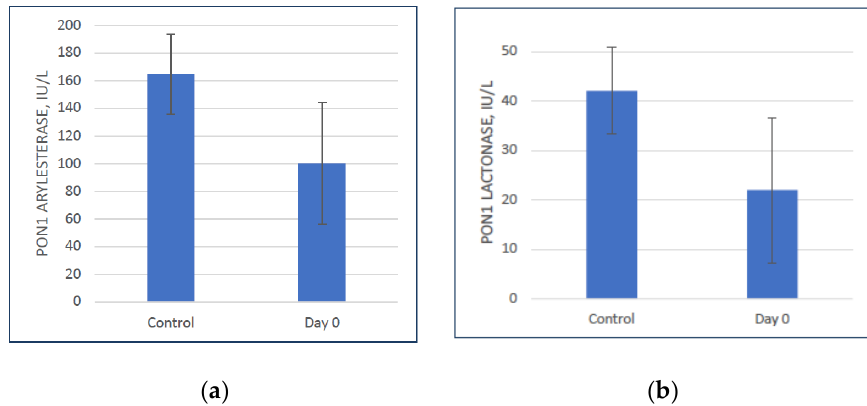
Figure 1. ( a ) Paraoxonase 1 (PON1) arylesterase activity (mean ± SD) in control group and experimental group Day 0 (Pre-surgery). PON1 activity is 40% lower in colon cancer patients compared to the control group ( p = 2.19 × 10 − 3 ). ( b ) PON1 lactonase activity (mean ± SD) in control group and experimental group Day 0 (Pre-surgery). PON1 activity is 48% lower in colon cancer patients compared to the control group ( p = 1.33 × 10 − 3 ).